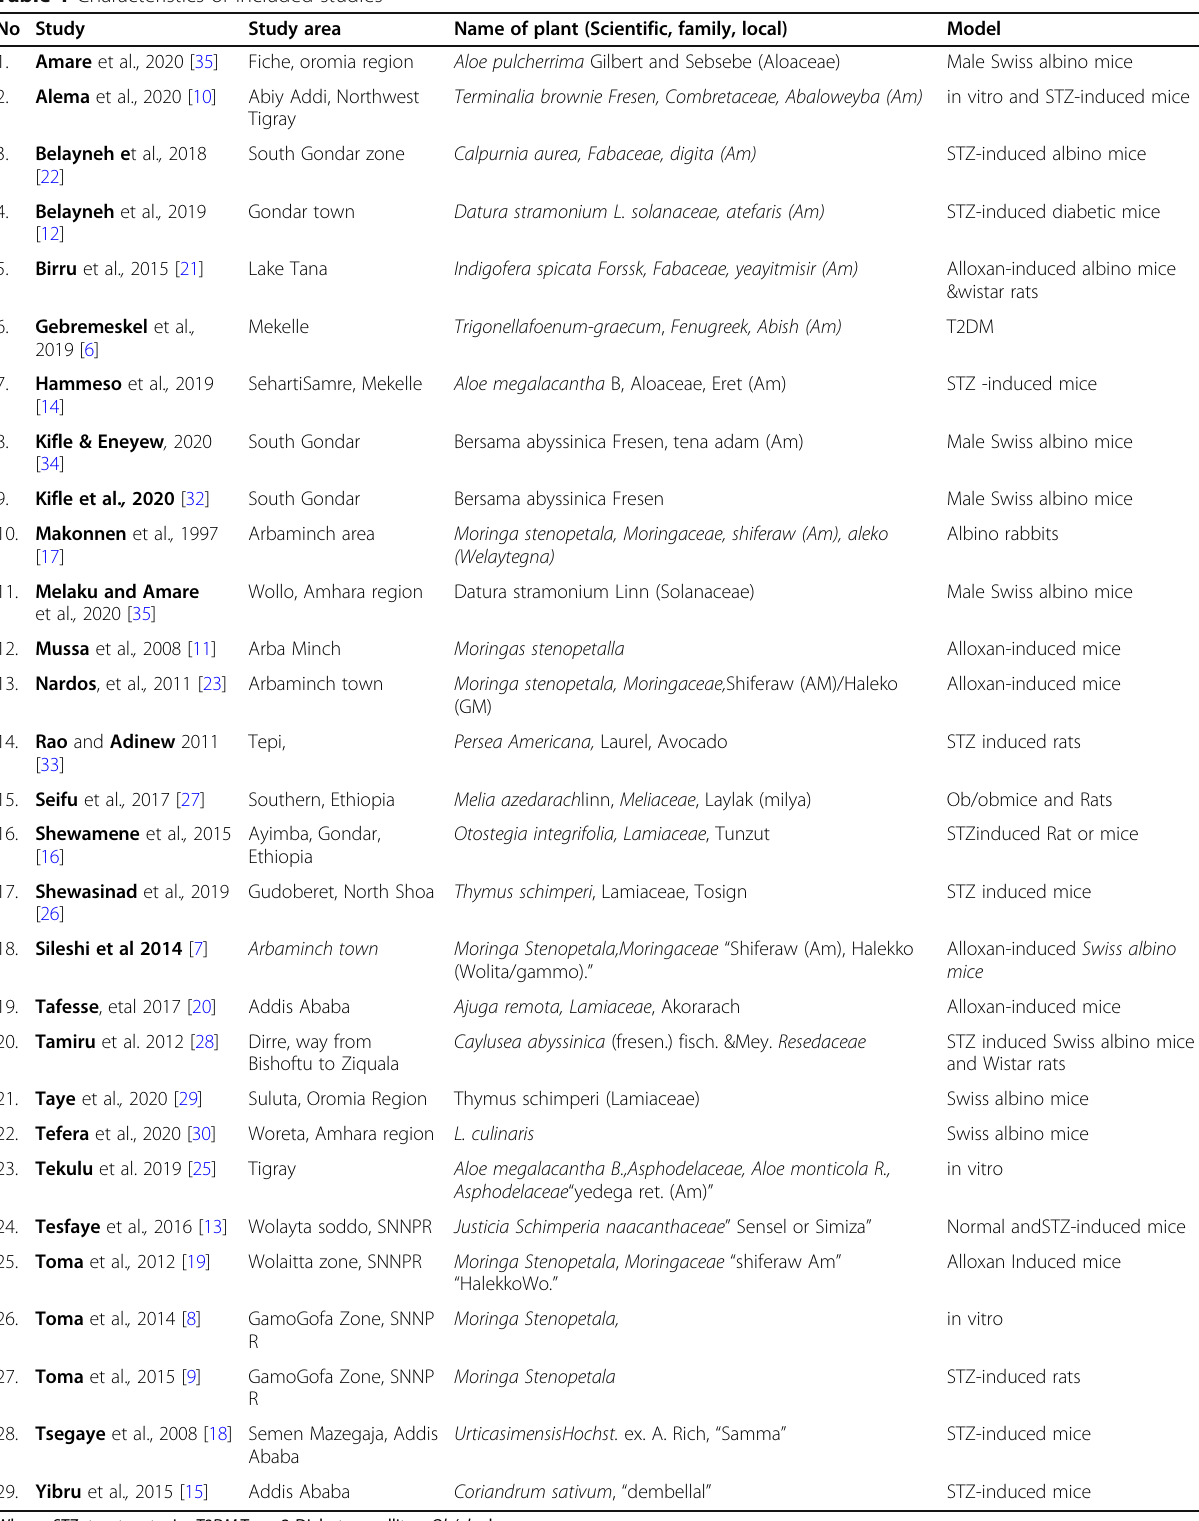
Table 1 Characteristics of included